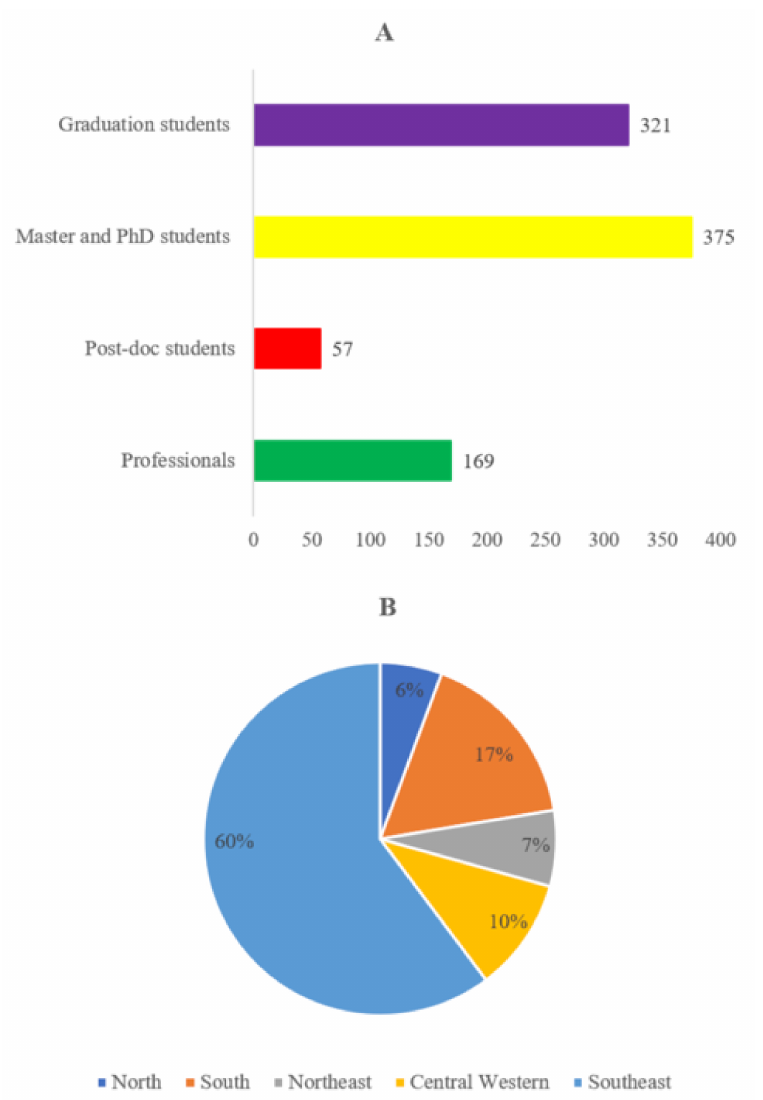
Figure 1. ( A ) Frequency of participants of the 31st Brazilian Society for Virology Congress and 15th Mercosul Virology Meeting by category and ( B ) their respective institution location in each country